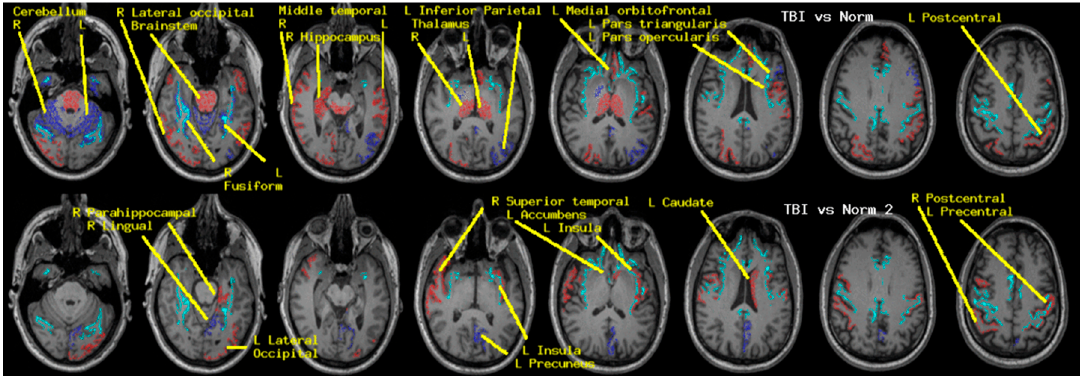
Figure 3. The regions whose neuroelectric activity values contributed to the cohort-specific classifiers reported in Tables 5 and 6 are shown. The MRI slices range left to right, inferior to superior, in one-centimeter increments. The left side of each slice is the right brain. Activity in blue/red regions was higher/lower in the TEAM-TBI cohort. The cyan landmarks are the boundaries between gray and white matter in the precentral, cingulate, insula, and fusiform regions.